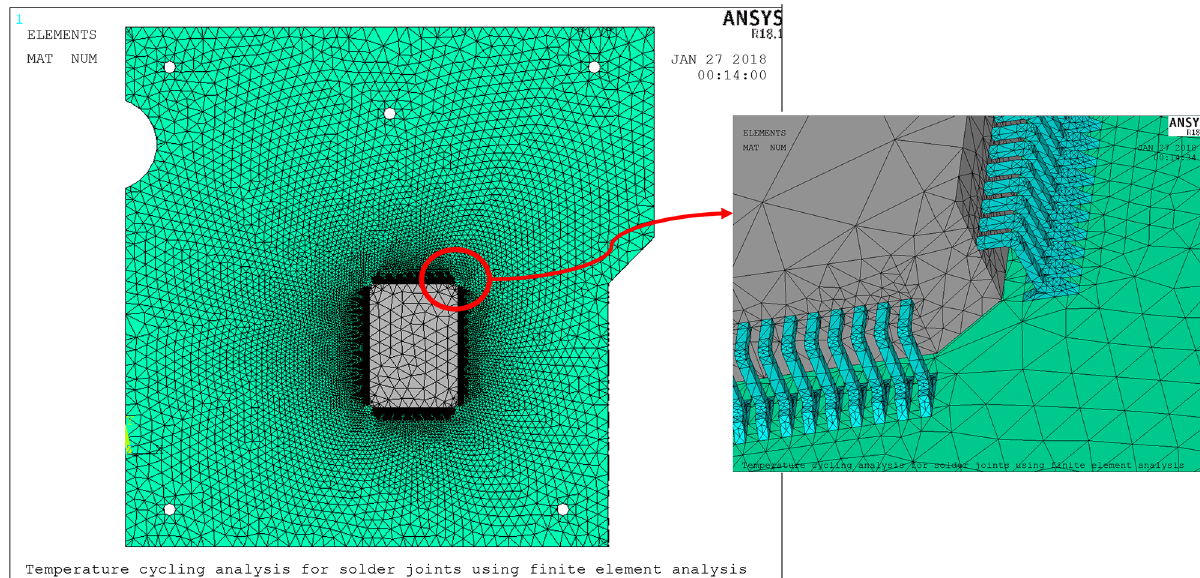
Fig. 4. Global model of the solder